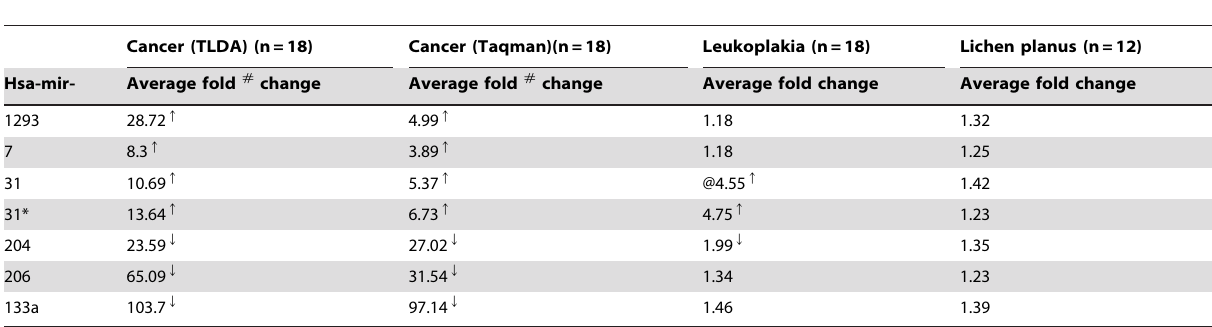
Table 4. Expression profile of 7 miRNAs in precancers and cancer samples.